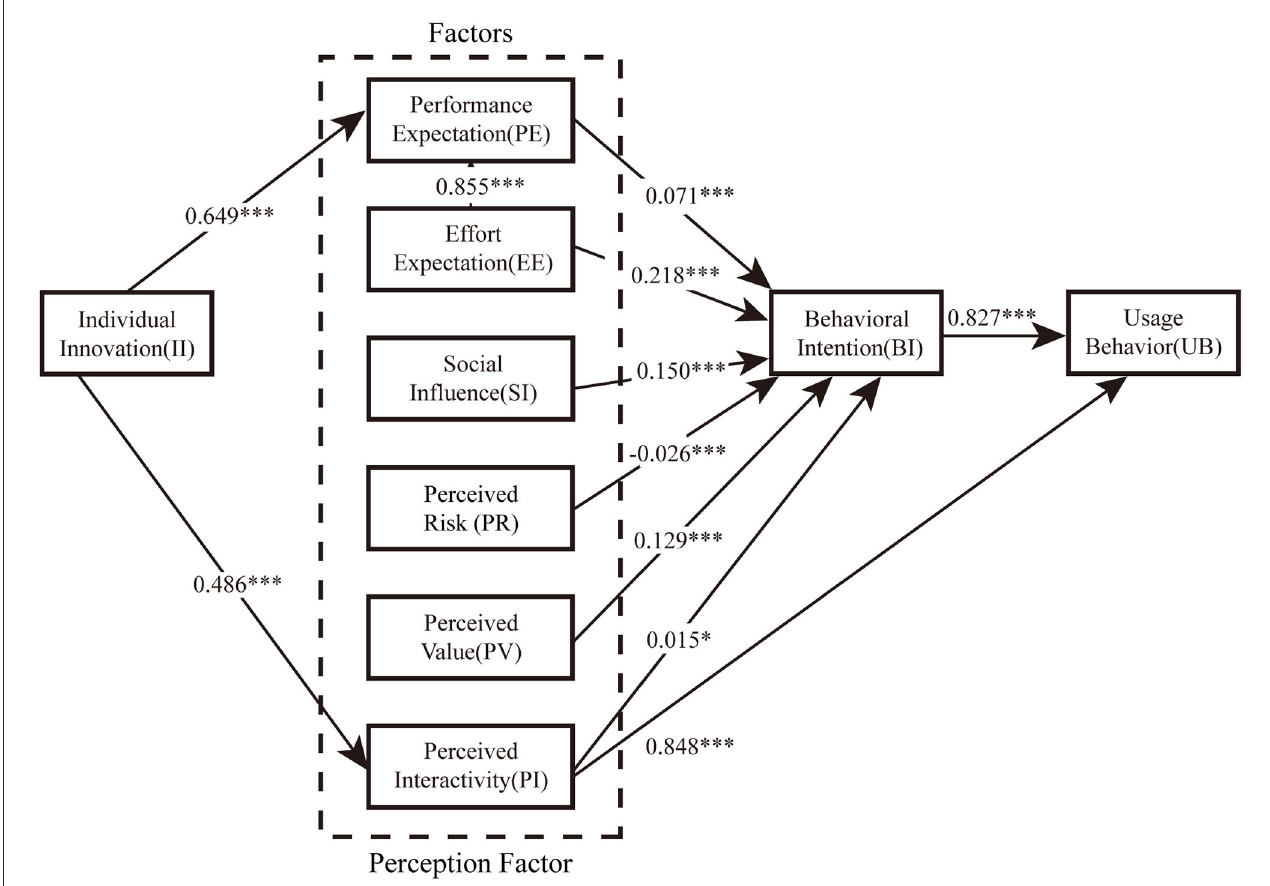
FIGURE2 The final model with parameter estimates of the significant paths. * p < 0.05 and *** p < 0.001.